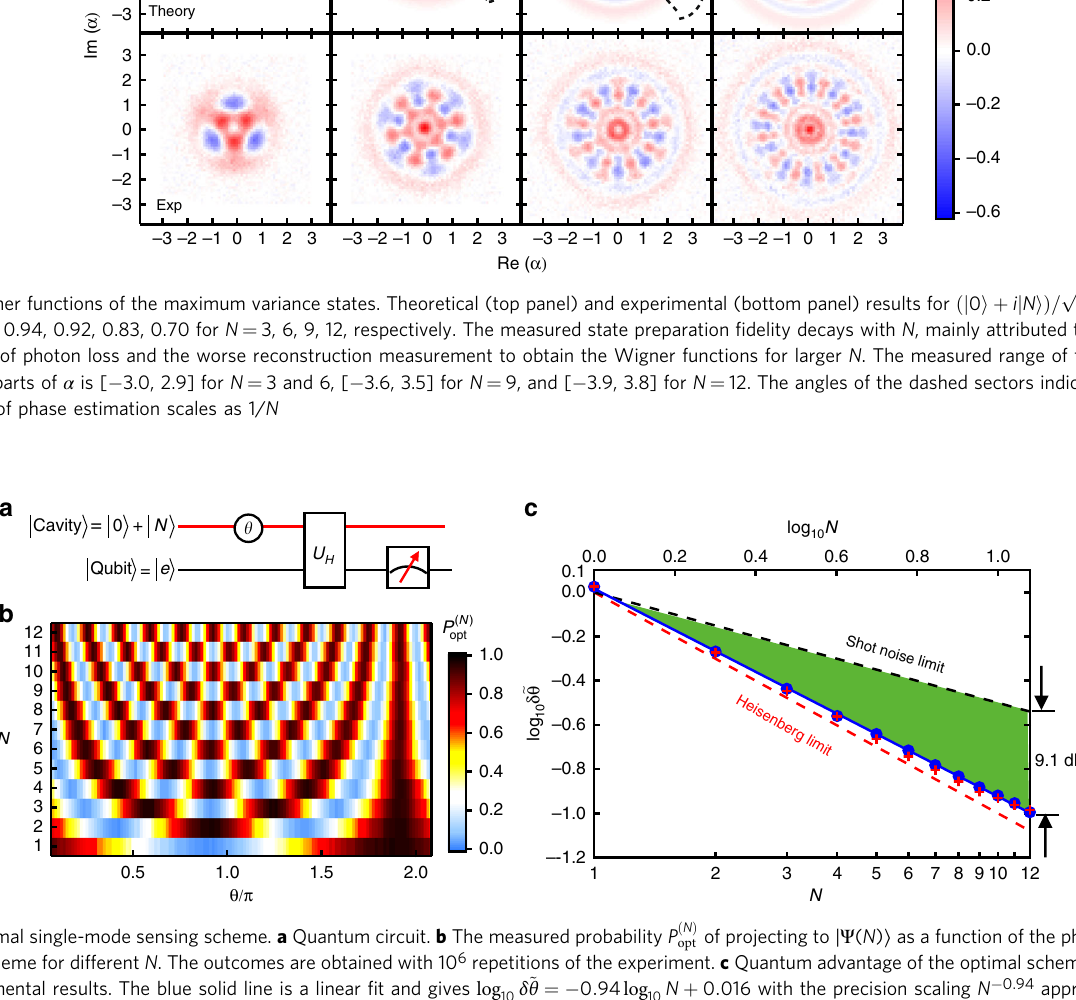
of projecting to | Ψ ( N ) 〉 as a function of the phase θ in the Fig. 3 Optimal single-mode sensing scheme. a Quantum circuit. b The measured probability P ð N Þ opt optimal scheme for different N . The outcomes are obtained with 10 6 repetitions of the experiment. c Quantum advantage of the optimal scheme. Blue dots δ ~ θ ¼ (cid:3) 0 : 94 log N þ 0 : 016 with the precision scaling N − 0.94 approaching the are experimental results. The blue solid line is a linear fi t and gives log 10 10 Heisenberg scaling ( N − 1 ). The small offset 0.016 in the log – log scale of the precision is dominantly due to the imperfections of the qubit readout process, where the spontaneous decay of the qubit gives wrong indication of the cavity state and lowers the contrast of the Ramsey interference. The red crosses are the results from numerical simulations including the decoherences of our system, in good agreement with the measured data. The error bars, obtained through the standard deviations of A and B in fi tting the data in b , are smaller than marker sizes. The black and red dashed lines are the theoretically calculated SNL and HL, respectively. Green region represents the experimental results that surpass the standard limit by about 9.1 dB at N = 12